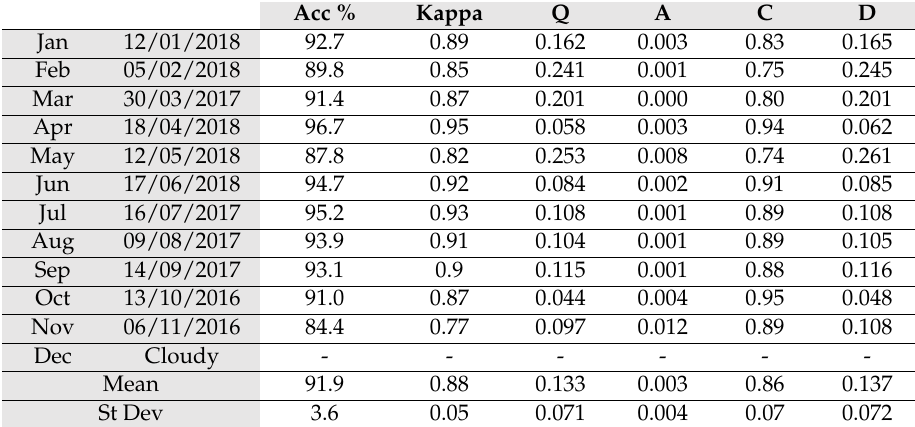
Table 3. Summary of quantity and allocation disagreement results, alongside overall accuracy and Kappa scores for comparison. Q: Quantity disagreement; A: Allocation disagreement; C: Overall agreement; D: Overall